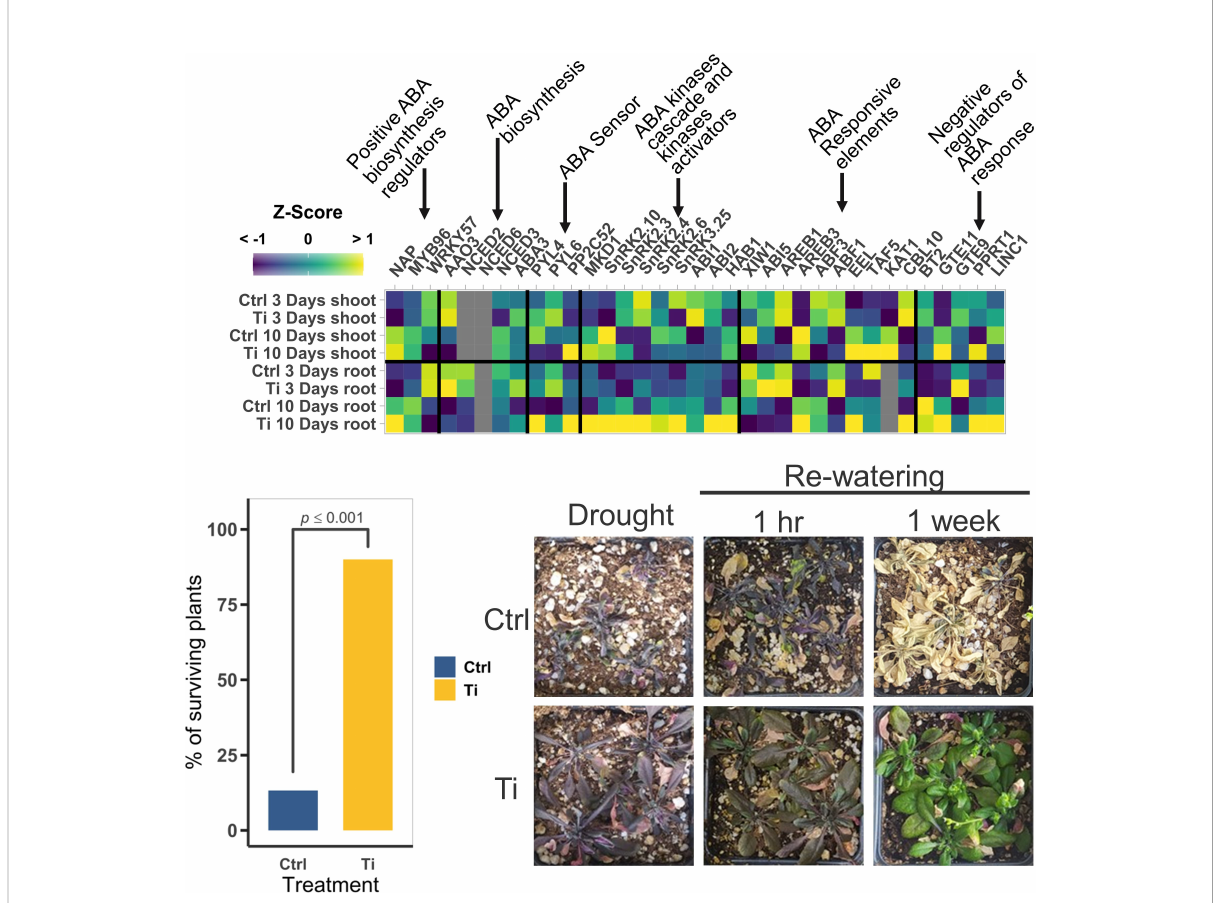
FIGURE 6 Effect of Titanium (Ti) on the expression of abscisic acid (ABA) and drought tolerance related genes in Arabidopsis. (A) Mean normalized expression of ABA related genes. Gray squares indicate that the gene was fi ltered-out in the fi ltering step of the edgeR pipeline due to low CPMs. (B) Percentage of surviving plants seven days after rewatering drought-stressed plants (n=60). (C) Representative photographs of plants exposed to drought before re-watering, and one hour and one week after